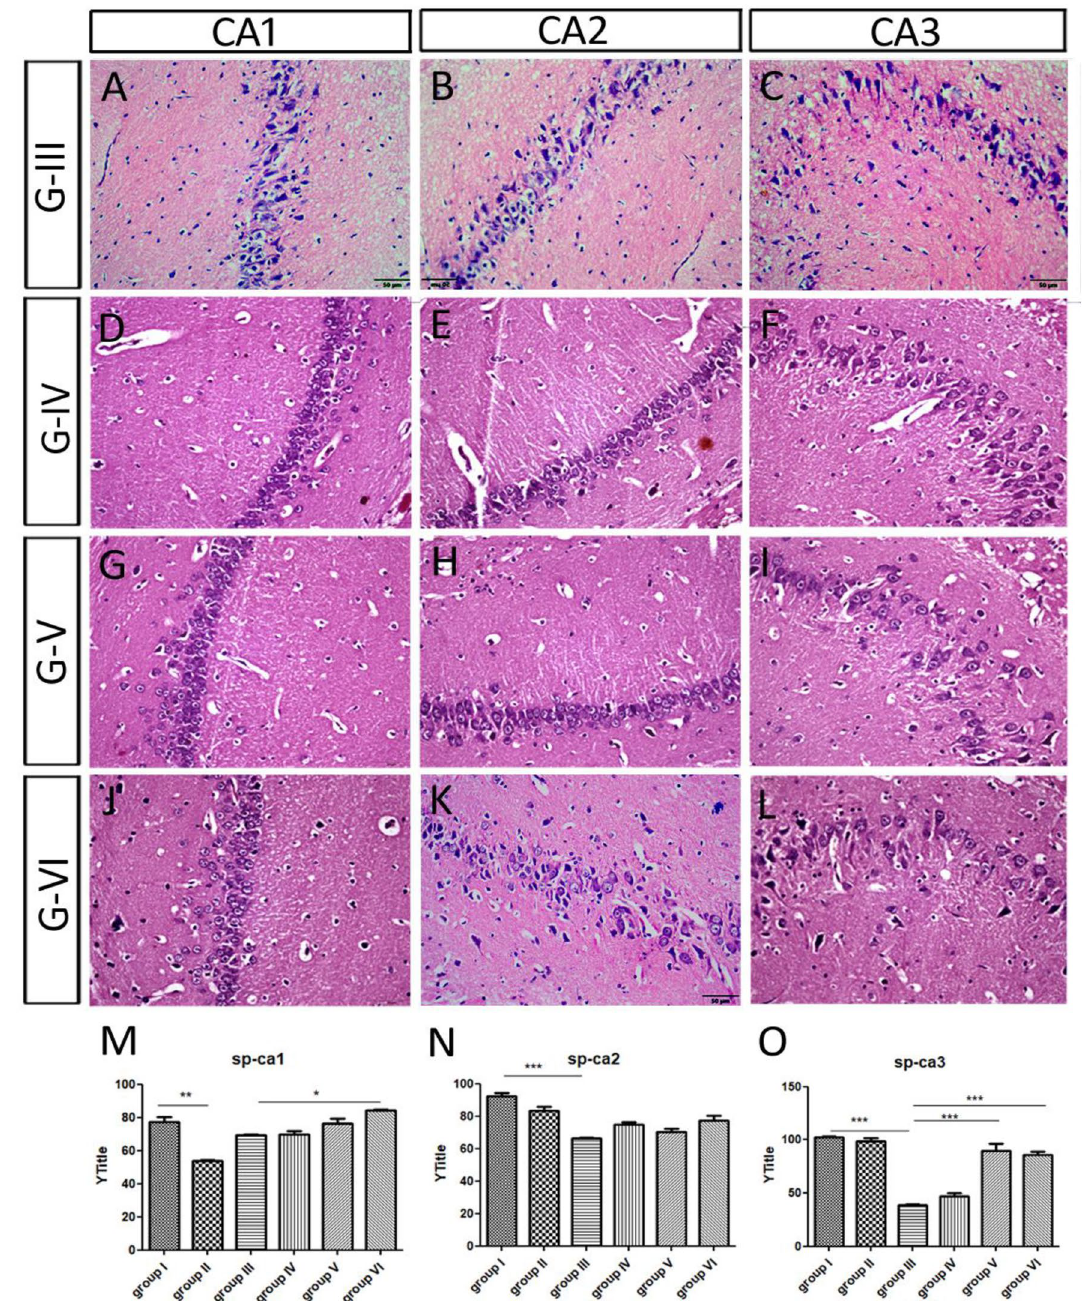
Figure 5. Showing pyramidal layers of the low and high dose ivabradine and donepezil treated groups. More normal healthy cells and less deformed cells were seen in the pyramidal layer of the three groups. ( A – C ) The pyramidal layer of ES group III. ( D – F ) In group IV, low ivabradine dose, the thickness and the number of the pyramidal layers in CA1, CA2 and CA3 were increased. ( G – I ) In group V, high ivabradine dose, the thickness of the pyramidal layer increase in CA1, CA3 and CA3 and there were significant distances between cells. ( J – L ) In group VI, donepezil, the shape was comparable to that of the high ivabradine dose. Additionally, the pyramidal layer of CA2 and CA3 showed few densely stained cells. ( M – O ) Quantification of the thickness of pyramidal layers in all groups of the experiment including the control (I), the scopolamine (II), the ES (III), the low ivabradine (IV) and high dose (V)of ivabradine and donepezil (VI) on of ES administrative